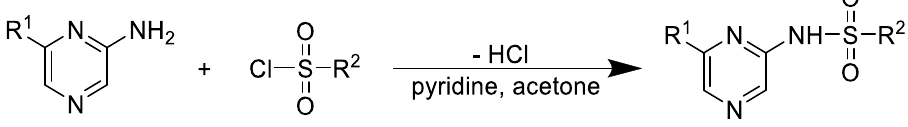
Scheme 1. General synthetic reaction. R 1 : H / Cl; R 2 : refer to Table